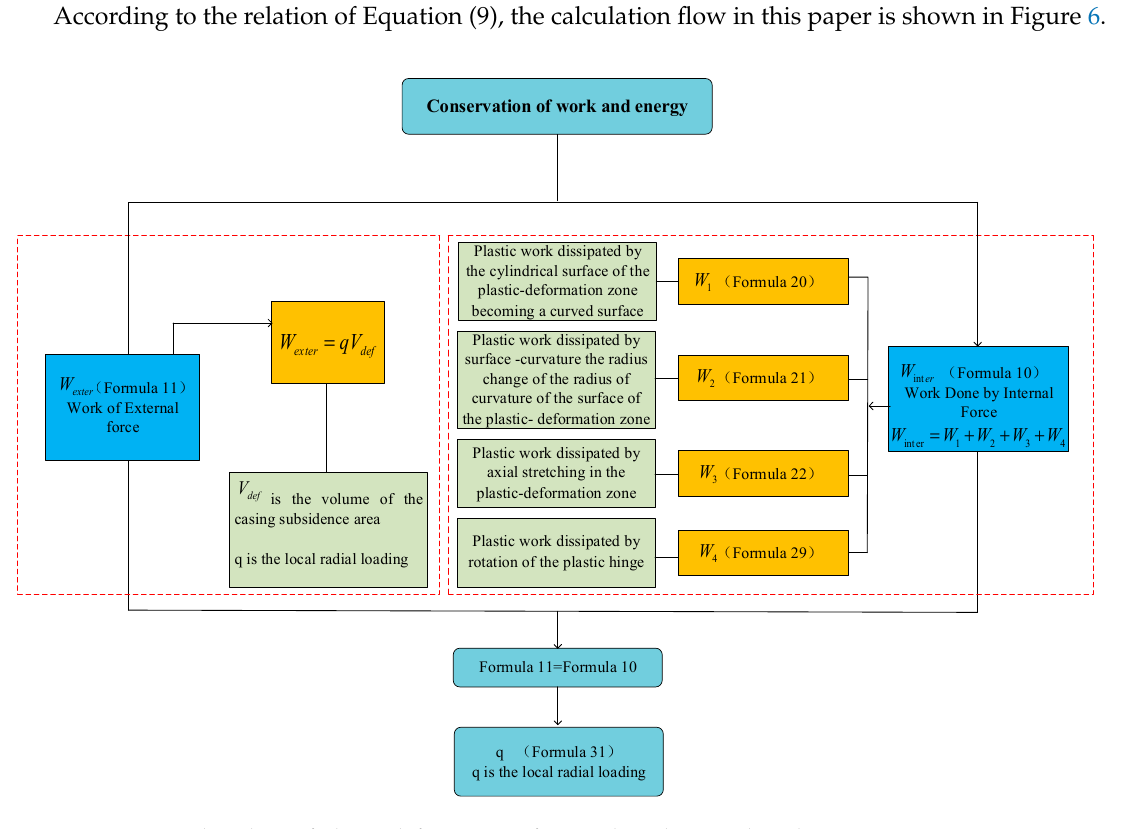
Figure 6. Flowchart of plastic deformation of casing based on work and energy conservation.